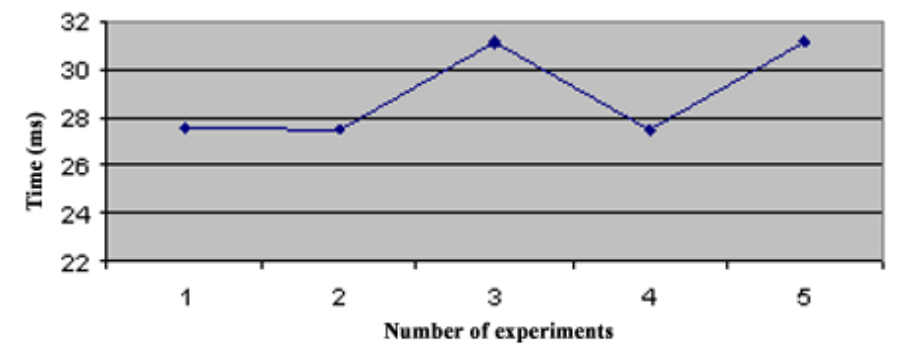
Figure 7. Convergence Time of Topology